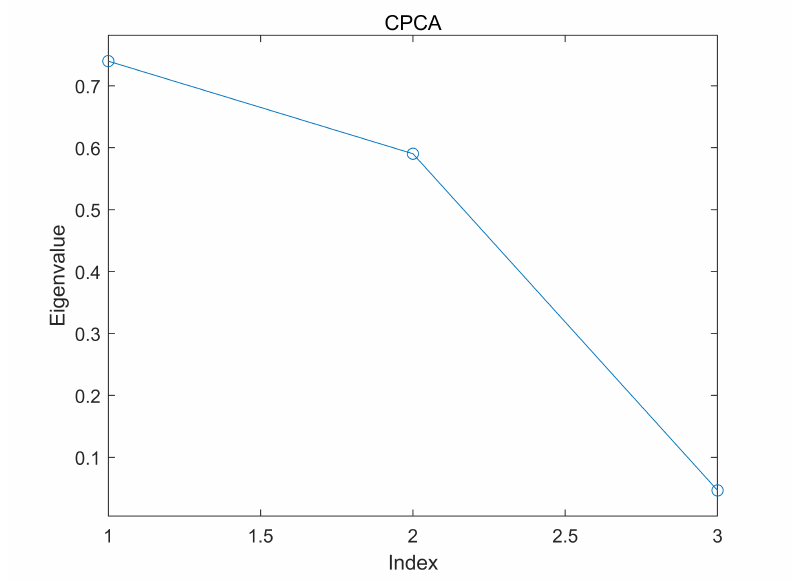
Figure 8. Scree plot of principal